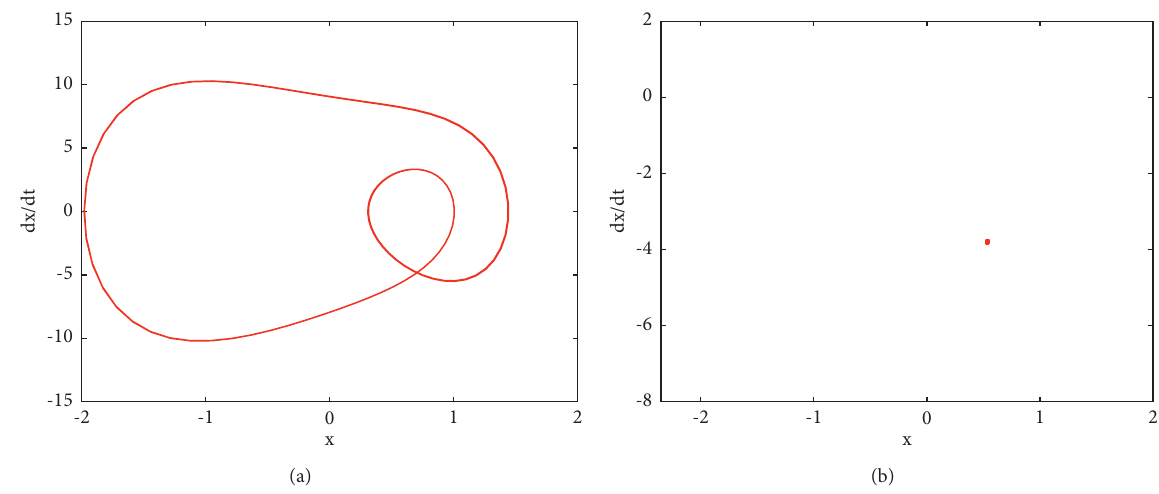
Figure 2: Phase portrait and Poincar´e cross section diagram of the system at F � 37.15 and τ � 1.2. (a) Phase portrait. (b) Poincar´e cross section diagram ( c � 0.5, c 1 � 30, c 2 � 20, μ � 0.001, k 1 � 10, ω � 3.9).